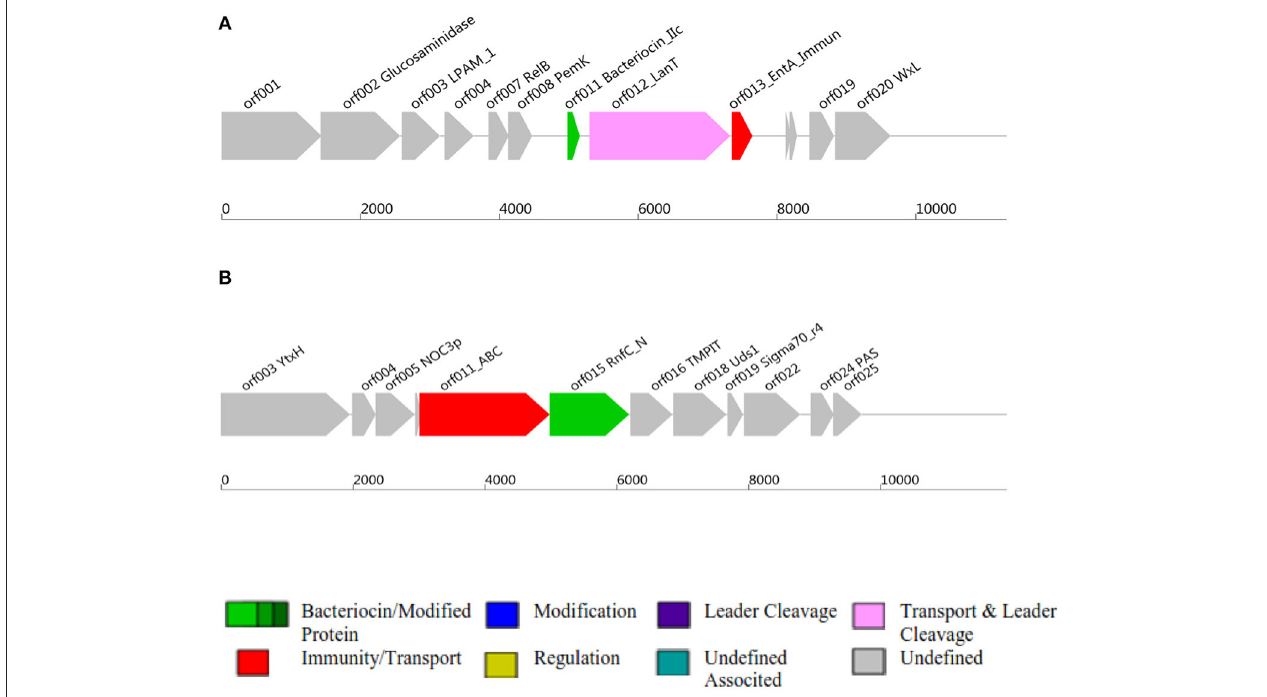
FIGURE 2 | Class II and Class III bacteriocins ORF, Open Reading Frame; AOI, Area Of Interst; (A) indicates class II bacteriocin, (B) Class III bacteriocin.